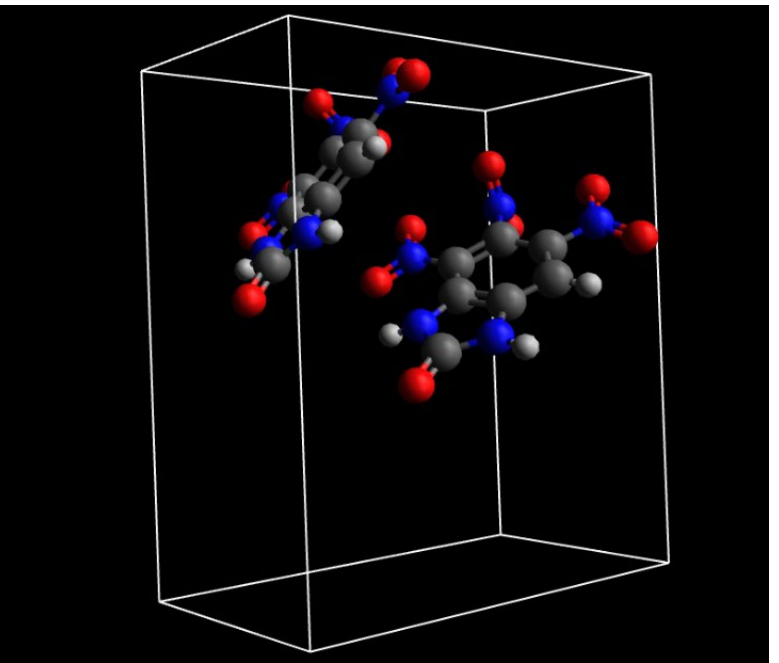
Figure 6. TriNBO-crystal cell unit packing illustration shows the dimeric mode of two TriNBO molecules with a slightly different space rearrangement.